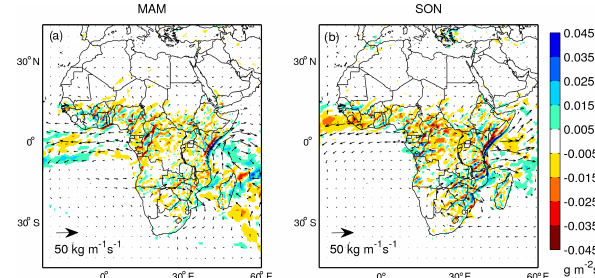
Figure 10. Changes in vertically integrated moisture flux (ar- rows, kgm − 1 s − 1 ) and moisture flux convergence (colour contours, gm − 2 s − 1 ) caused by vegetation feedback, averaged over the future period (as defined in Sect. 2.2) for (a) MAM and (b) SON.